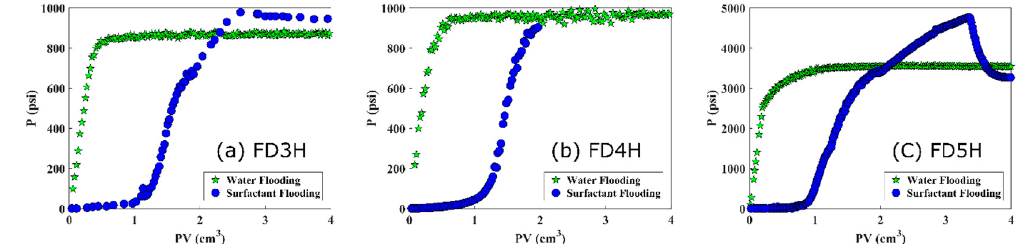
Figure 4. Pressure P (psi) during water flooding and surfactant flooding as a function of pore volume PV (cm 3 ) injected.